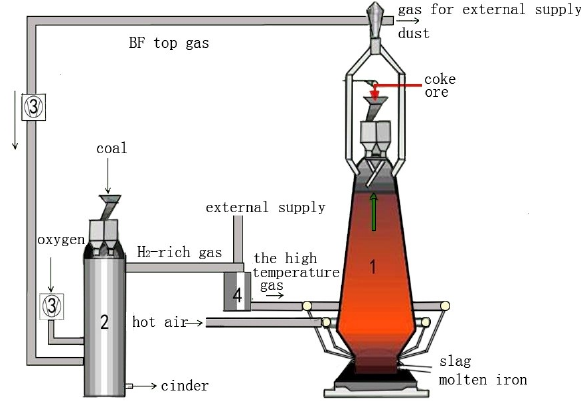
Figure 1: A diagram describing the operation of the gas-injection